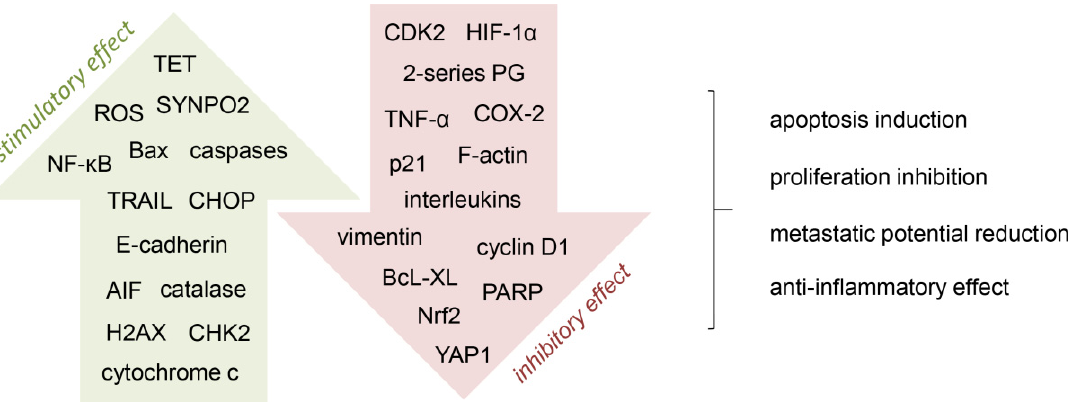
Figure 2. Mechanisms involved in the anti-cancer activity of vitamin C. A number of cell processes are targeted by vitamin C, by stimulating (green arrow) or inhibiting (red arrow) different pathways. AIF, apoptosis-inducing factor; CDK2, cyclin-dependent kinase 2; CHK2, checkpoint kinase 2; CHOP, C/EBP homologous protein; COX-2, cyclooxygenase-2; H2AX, histone 2AX; HIF-1 α , hypoxia-induced factor 1 α ; NF- κ B, nuclear factor- κ B; Nrf2, nuclear factor erythroid 2-related factor 2; PARP, poly(ADP-ribose) polymerase; PG, prostaglandins; ROS, reactive oxygen species; SYNPO2, synaptopodin 2; TET, ten-eleven translocation; TRAIL, tumor necrosis factor (TNF)-related apopto-